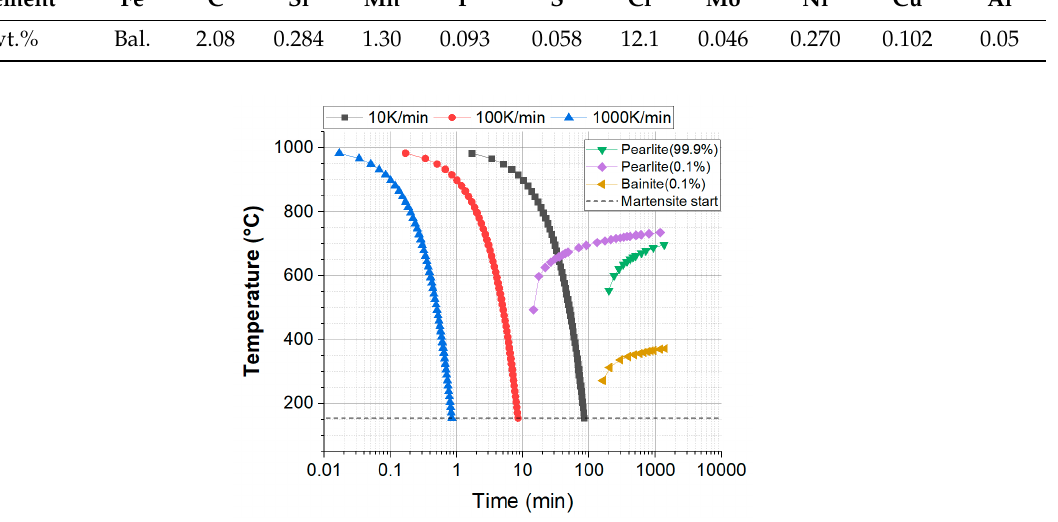
Table 1. Chemical composition of HCCI alloy analyzed via arc spark emission spectrometer. Element